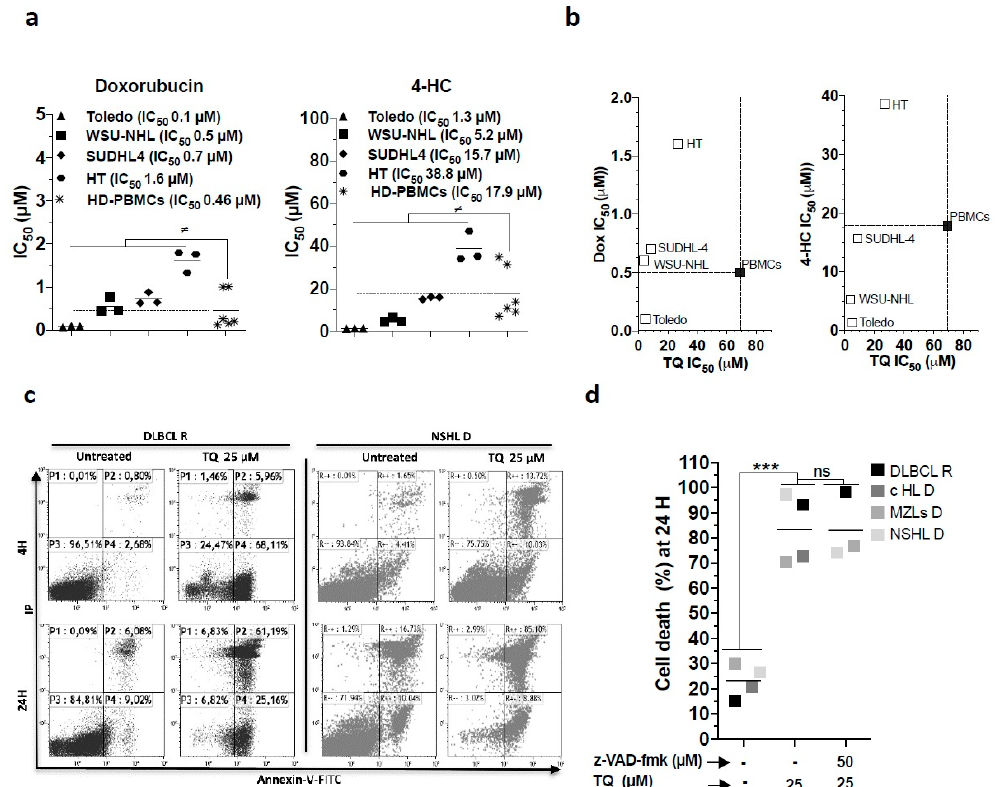
Figure 6. Potential benefit of the cytotoxic effect of TQ. ( a,b ) Effect of 4-hydroxy-cyclophosphamide (4-HC) and doxorubicin (Dox) on cell viability of cell lines and activated HD PBMCs. ( a ) Comparison of IC 50 of 4-HC and Dox in cell lines and HD PBMCs. ( b ) IC 50 plots comparing TQ versus Dox and TQ versus 4-HC. The dotted line represents the cut-off that refers to the IC 50 inhibitor in HD PBMCs and defines the selectivity profile of each inhibitor. ( c , d ) Cell death effect of TQ alone or combined with z-VAD-fmk in primary lymphoid cells, including DLBCL at relapse (R), cHL (classical Hodgkin’s lymphoma), NSHL (nodular sclerosing Hodgkin lymphoma), and MZLs (marginal zone lymphomas) at diagnosis (D). ( c ) Annexin-V-FITC/IP plot profile of untreated cells and TQ-treated DLBCL R and NSHL D cells, primary lymphoid blasts were identified with antibodies against CD45 and CD19. ( d ) Cell death plot comparison of untreated cells and cells treated with 25 µM TQ or z-VAD-fmk. Student’s t -test: ns p > 0.05, * p < 0.05, ** p < 0.01, *** p < 0.001; ANOVA: ≠ p < 0.05, PBMCs (6 HD) vs. cell lines ( n = 3).